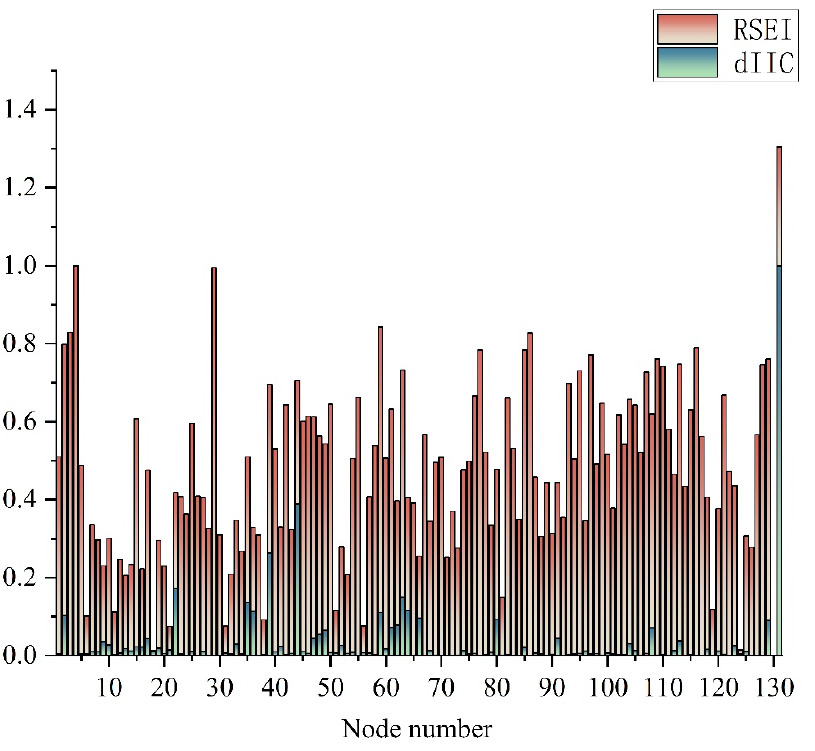
Figure 13. RSEI and dIIC coupling indicators.